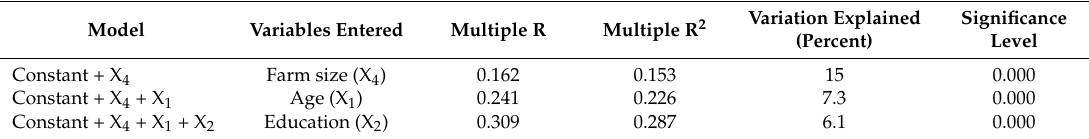
Table 6. Summary of the step-wise multiple regression analysis ( n =